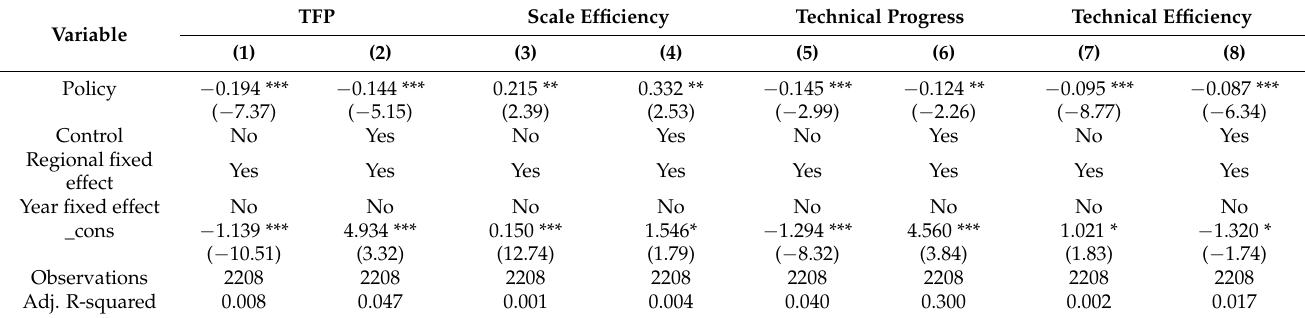
Table 7. Single-difference test.